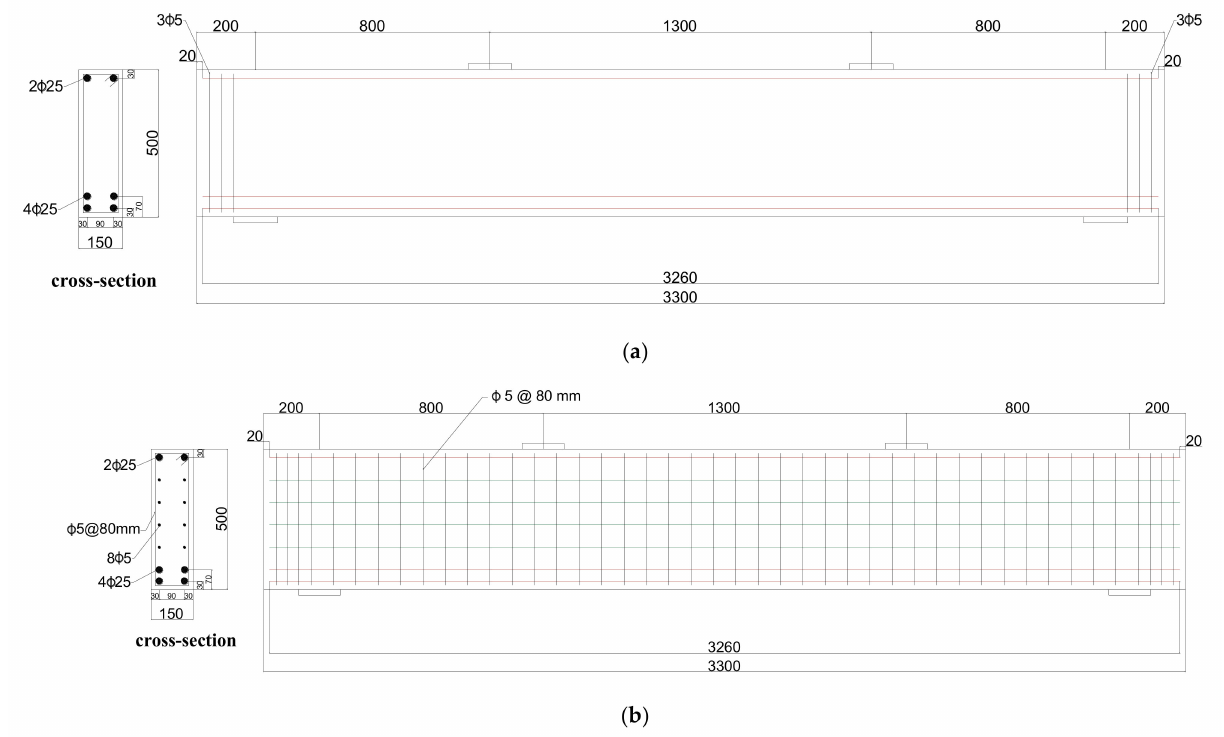
Figure 1. Details of test specimens (dimensions are in mm): ( a ) Specimens without steel stirrups; ( b ) Specimens with steel